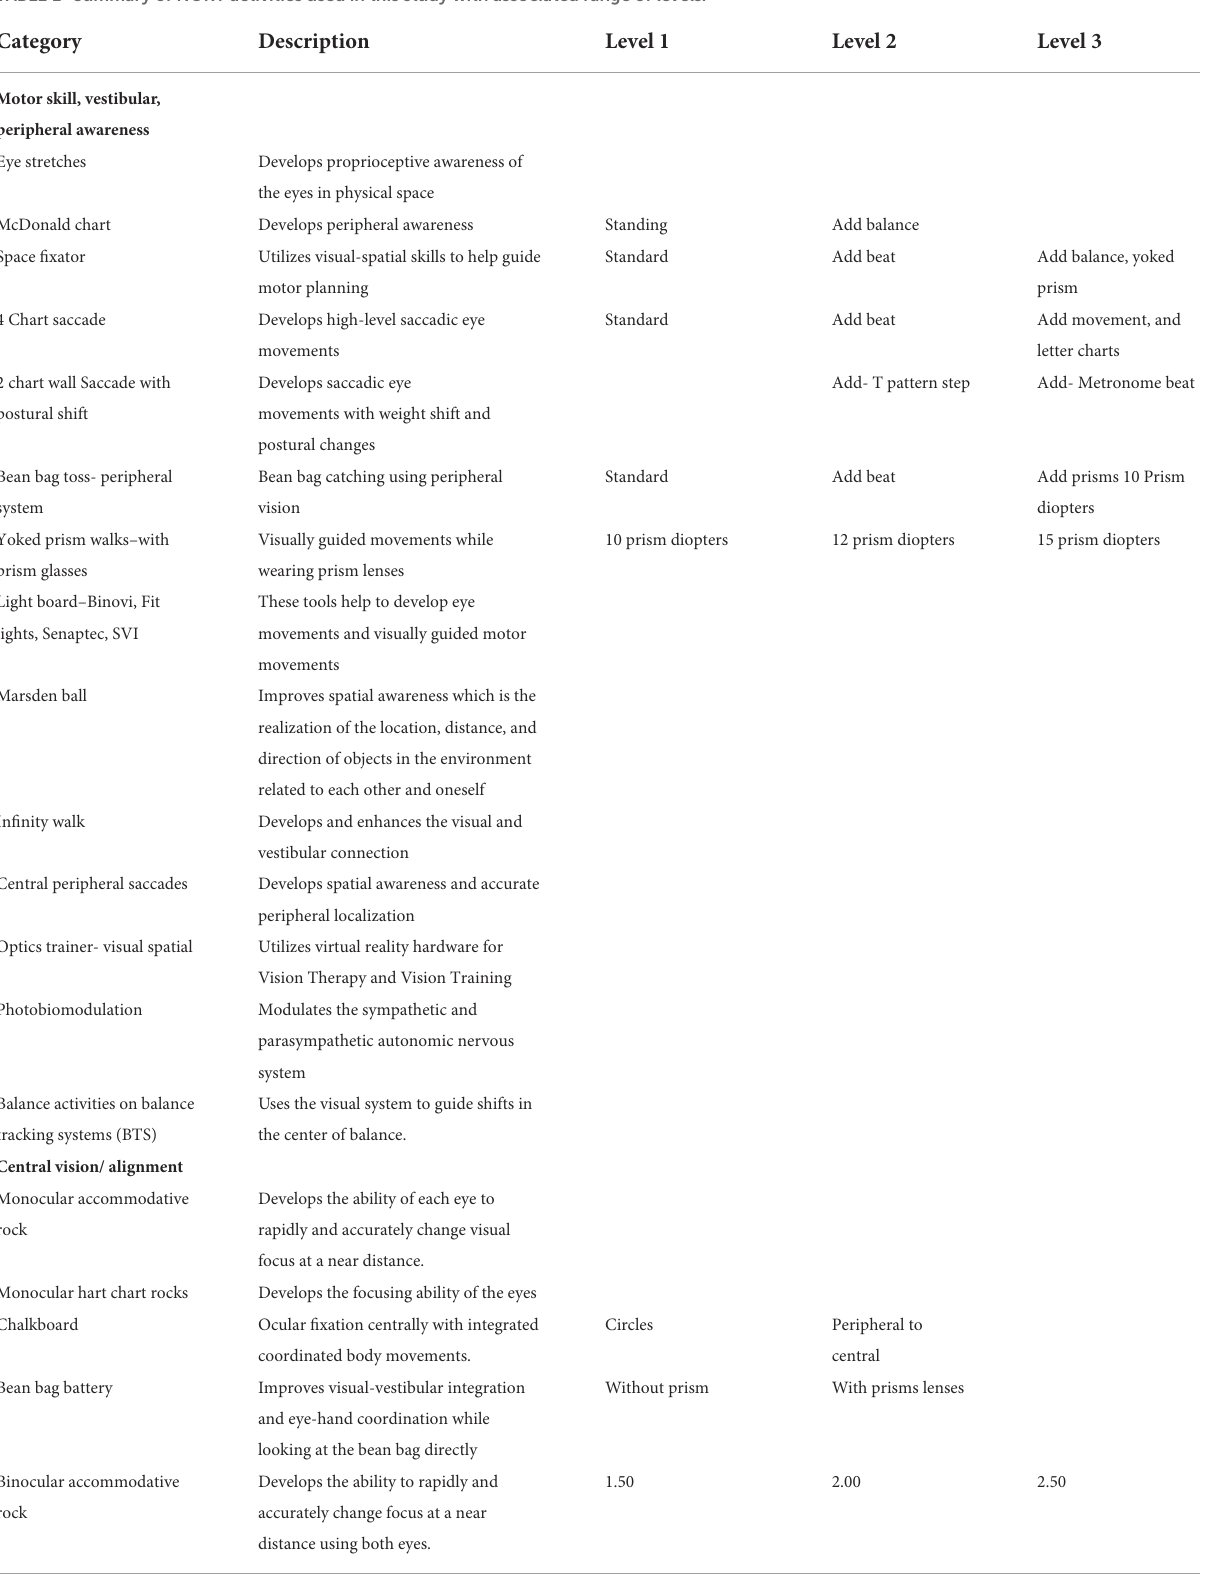
TABLE 1 Summary of NORT activities used in this study with associated range of